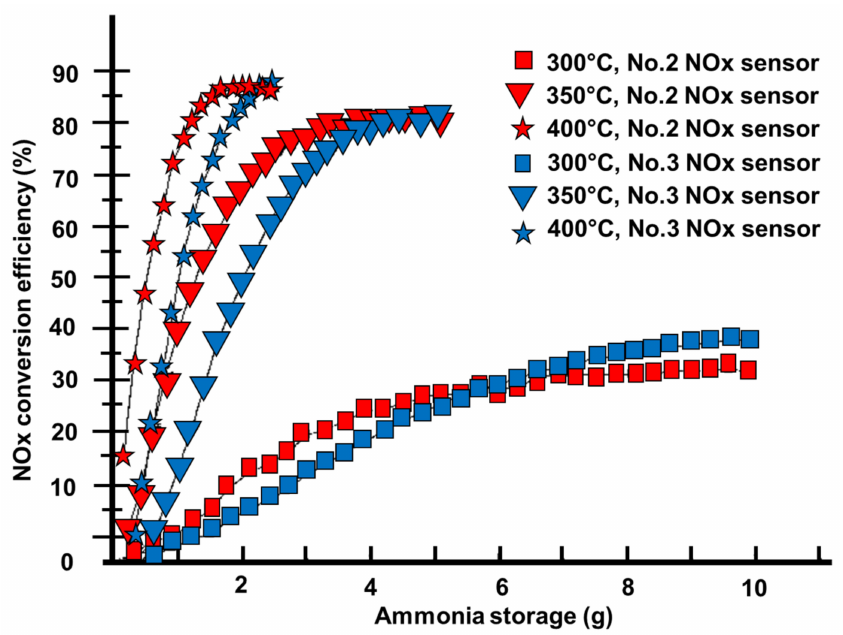
Figure 8. The shifting phase of NOx actual conversion efficiency, in addition to ammonia storage at various catalyst temperatures